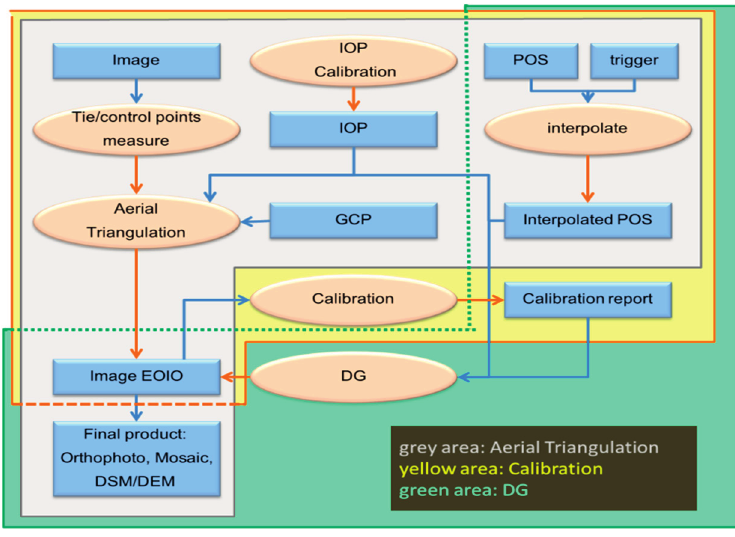
Figure 14. The process of INS/GPS POS assisted AT, system calibration and DG.